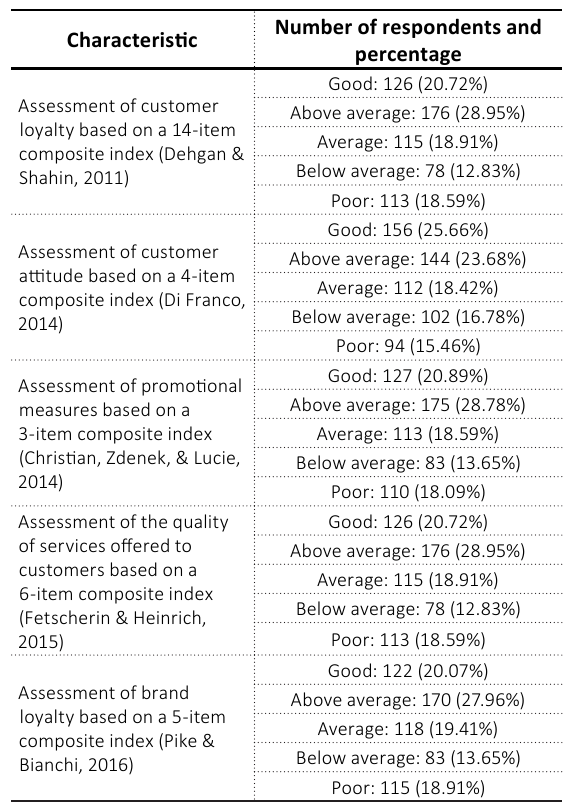
Table 5. Assessment of customer loyalty